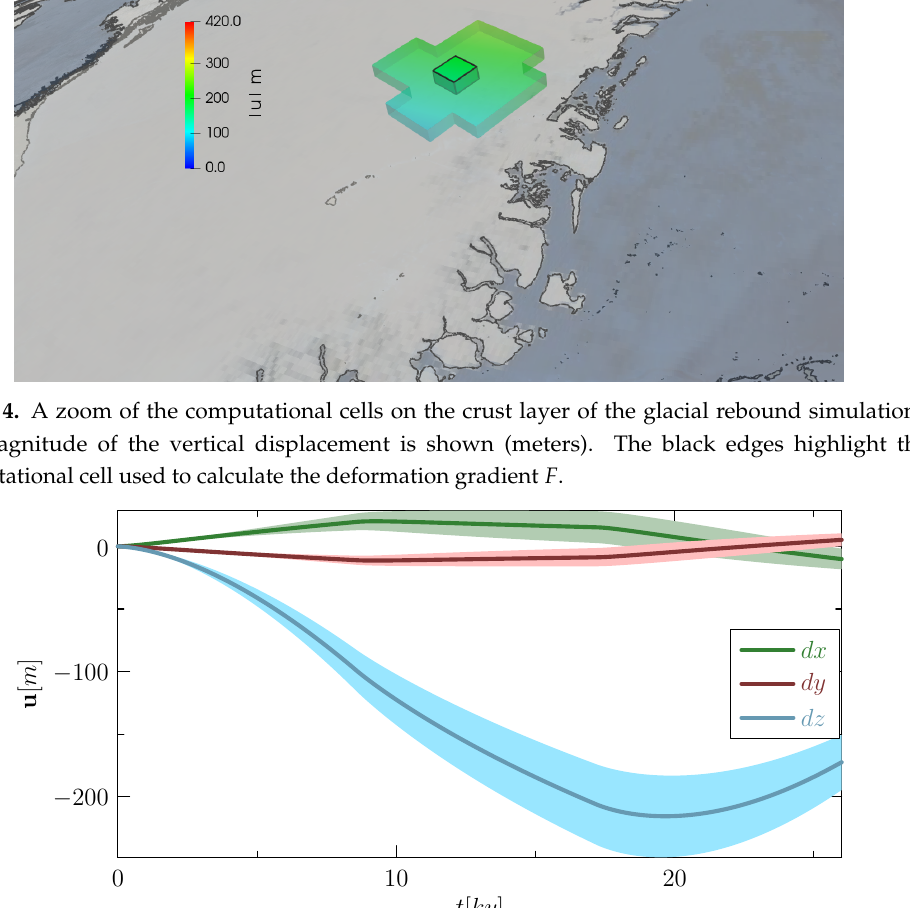
Figure 5. We show the average displacement field over time in the x , y and z direction at the nodal points of of the selected cell. Precisely, the light regions mark the minimum and the maximum displacement sampled at the nodes of the selected computational